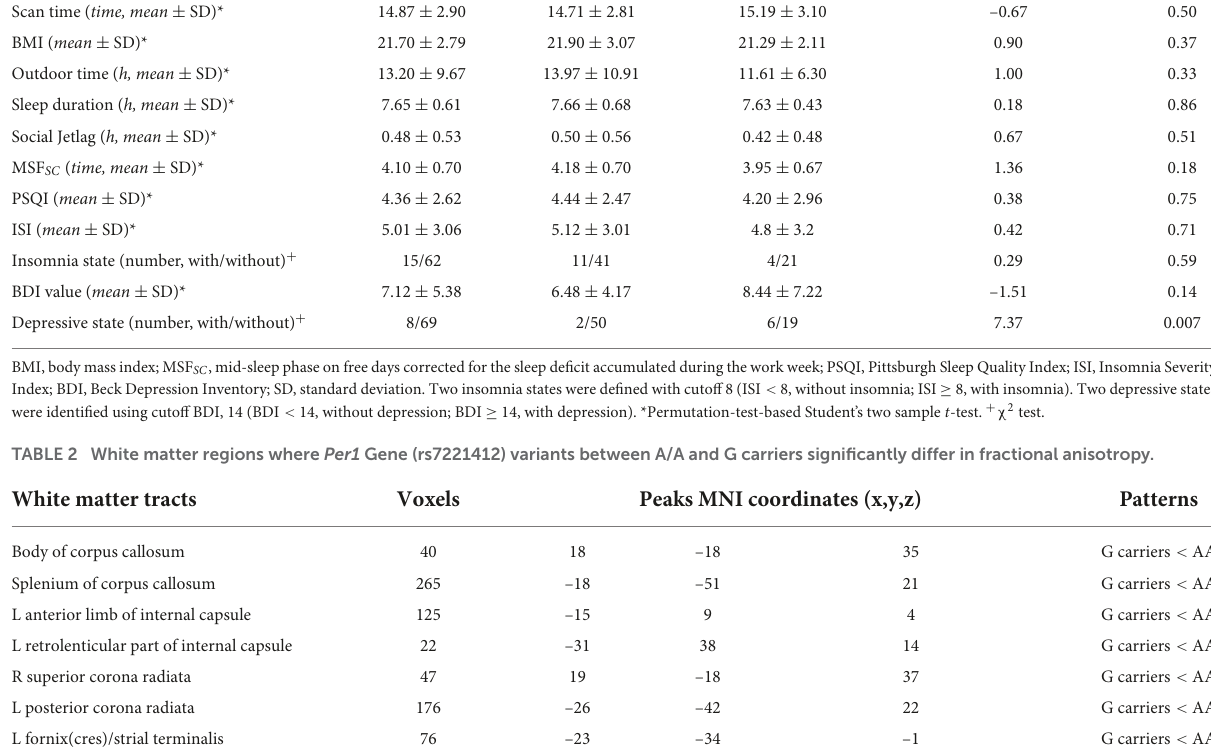
TABLE 1 Demographic characteristics and circadian rhythms associated phenotypes according to the polymorphism of PER1 gene (rs7221412). Variables Total ( n = 77) AA ( n = 52) G carriers ( n = 25) T value or χ 2 value P value 50/27